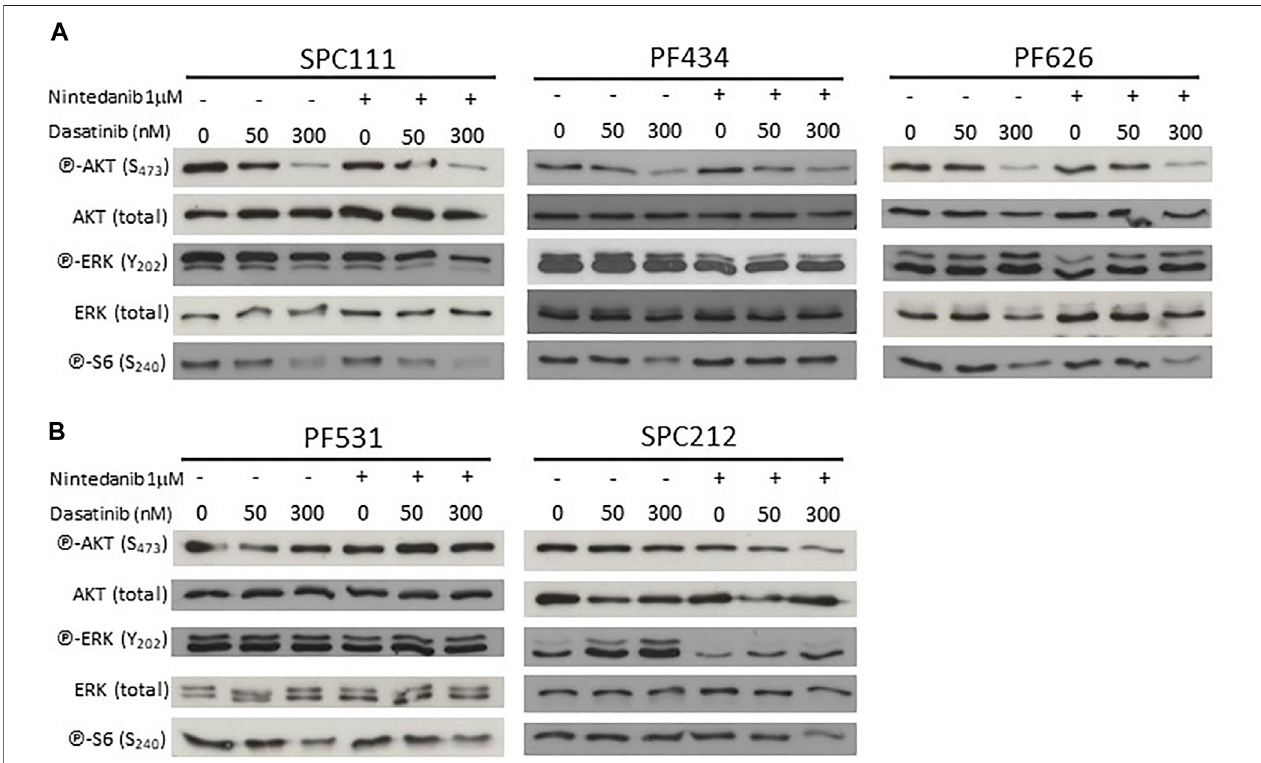
FIGURE 8 | Nintedanib treatment does not affect the AKT-mTORC1 or the ERK pathways while dasatinib decreases AKT and pS6 activation in SPC111, PF434 and PF626 cell lines (A) but not in PF531 and SPC212 cells (B) .